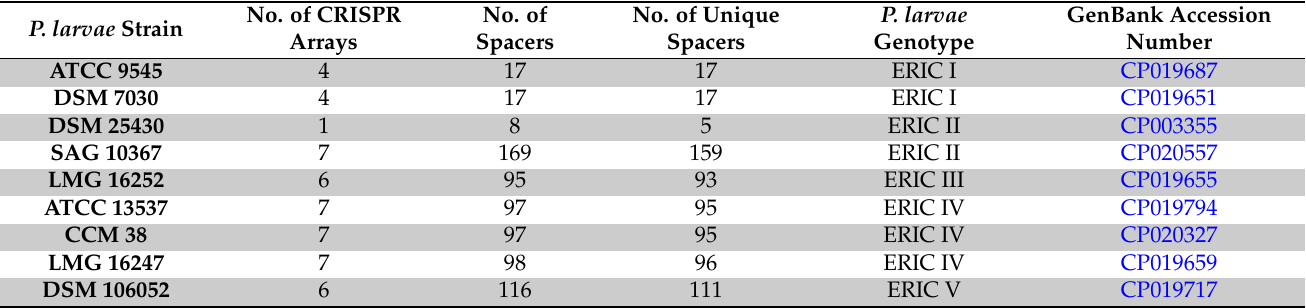
Table 1. CRISPR array and spacer data for the P. larvae strains with a completely sequenced genome used in this study.